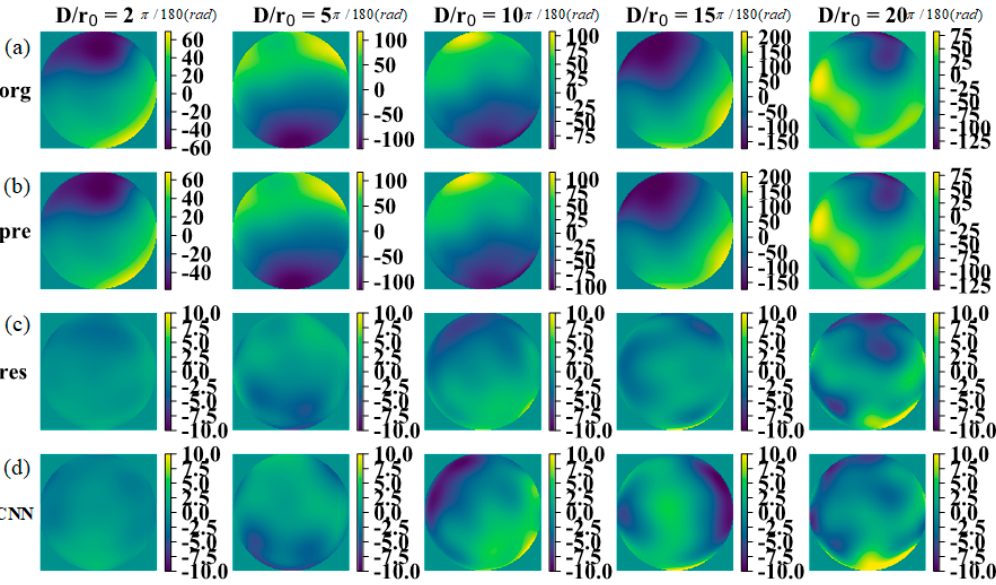
Figure 6. Comparison of the predicted turbulence phase with the actual phase: ( a ) actual phase; ( b ) predicted phase; ( c ) residual phase; ( d ) prediction results of the literature [12]. Table 2. PV and RMS values of the residual phase at different turbulence intensities.